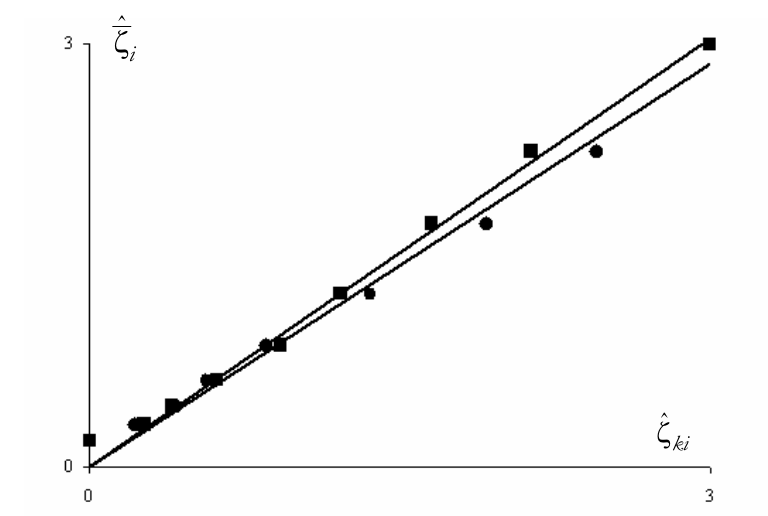
Figure 5 – Logistic-Weibull distribution function: example of the alignment of the unifying percent- ˆ age points (cid:93) considered as a function of the percentage points ˆ i ries, i (cid:32) 1, 2, ..., 9 , k = 6, 7, and obtained from Table 5 using the numerical method mentioned above which led to the values of Table 6.